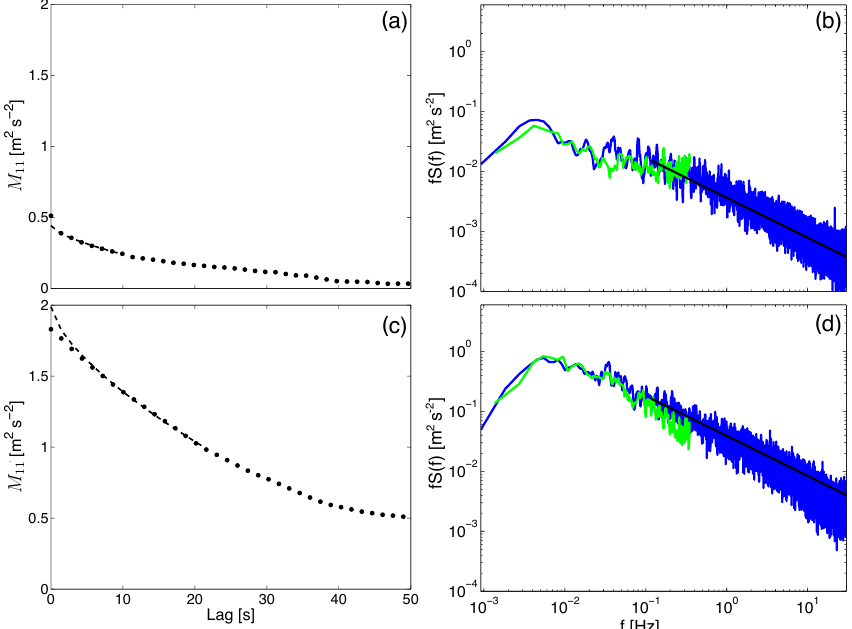
Figure 4. (a, c) The dashed black lines are example fittings of the structure (Eq. 4) to M 11 values from the DL observations, which are shown by black dots. (b, d) Spectra from the lidar measurements (green) are compared with those from sonic anemometer measurements (blue) for the same periods shown in (a, c) respectively, with the black solid line denoting the theoretical − 2/3 slope in the inertial subrange. Spectra are smoothed for clarity using a 5-point moving average. The fitting shown in (a) is expected when white noise is present, as the peak at lag zero is attributed to noise. Within (c) , M 11 at lags zero and one are less than is expected from isotropic turbulence. This is attributed to the volume and time-averaging effects of the DL when noise values are very low, visible within the spectra in (d)